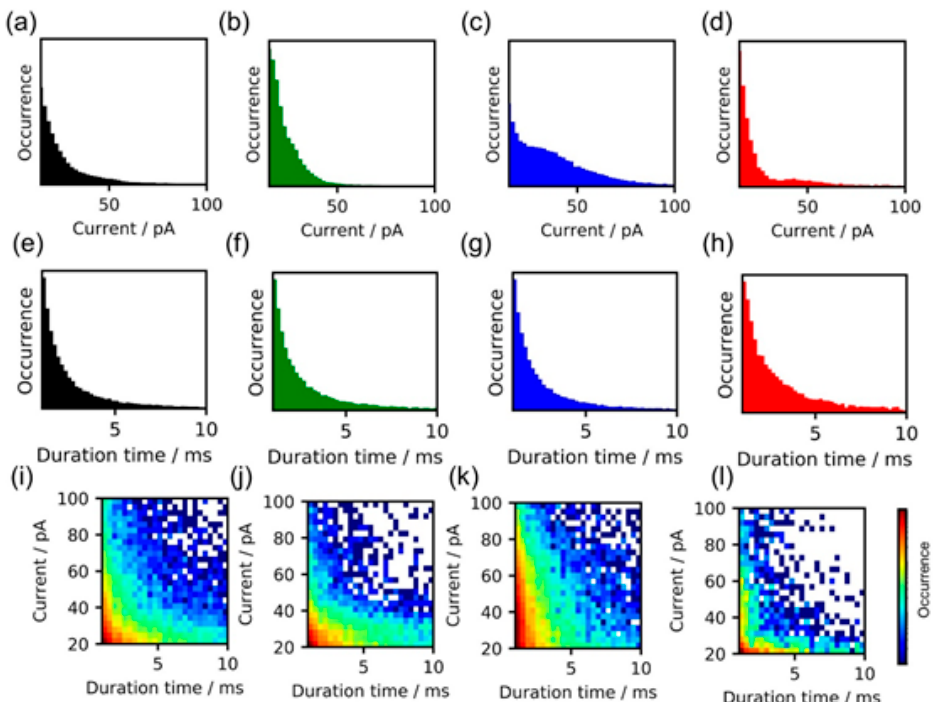
Figure 3. Statistical analysis results for obtained signals. In these analyses, at least 1000 signals were utilized. The occurrence in the histogram represents normalized signal numbers. ( a – d ) Current histograms at bias voltage of 100 mV for cAMP ( a ), AMP ( b ), ADP ( c ), and ATP ( d ). ( e – h ) Duration-time histograms of cAMP ( e ), AMP ( f ), ADP ( g ), and ATP ( h ). ( i – l ) Two-dimensional plots of I p and t d for cAMP ( i ), AMP ( j ), ADP ( k ), and ATP ( l ), and dependency of sample species.